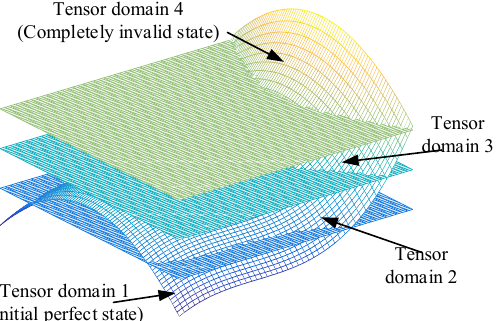
Figure 2. Schematic diagram of the aging state classification.